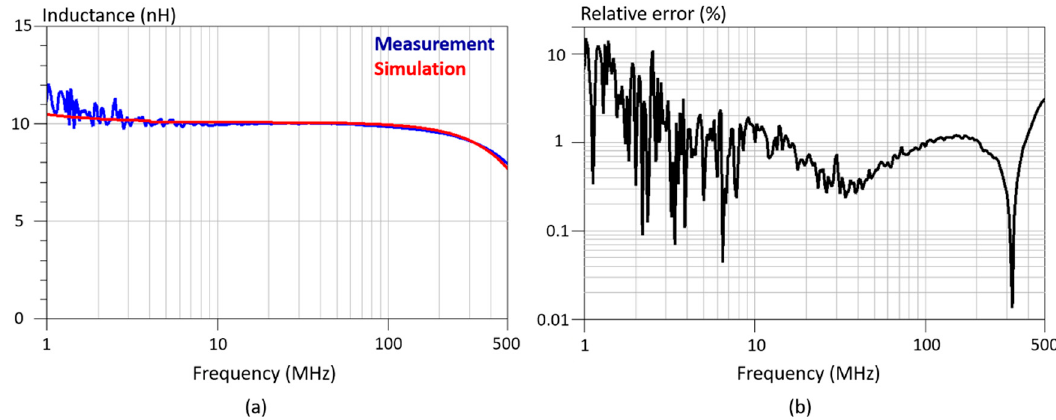
Figure 10. Lateral PCB loop inductance extraction: ( a ) measurement vs. simulation; ( b ) relative error.